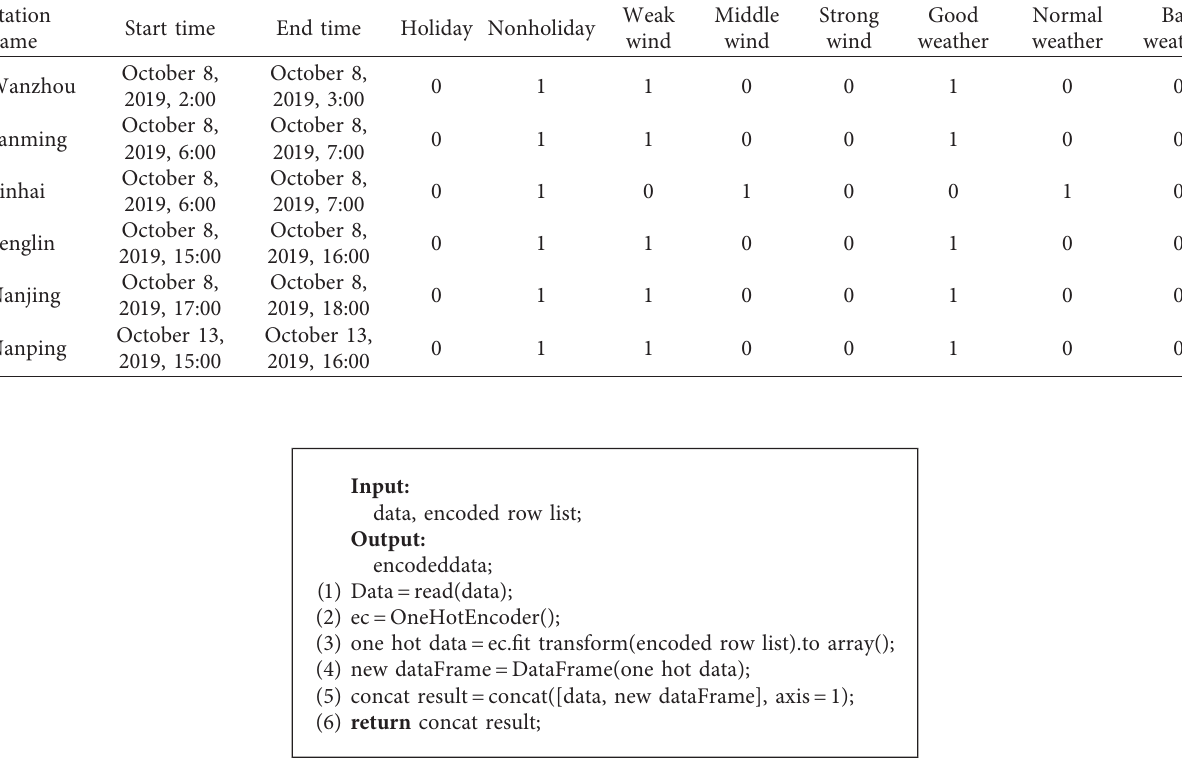
Table 7: Coding results of model input data.